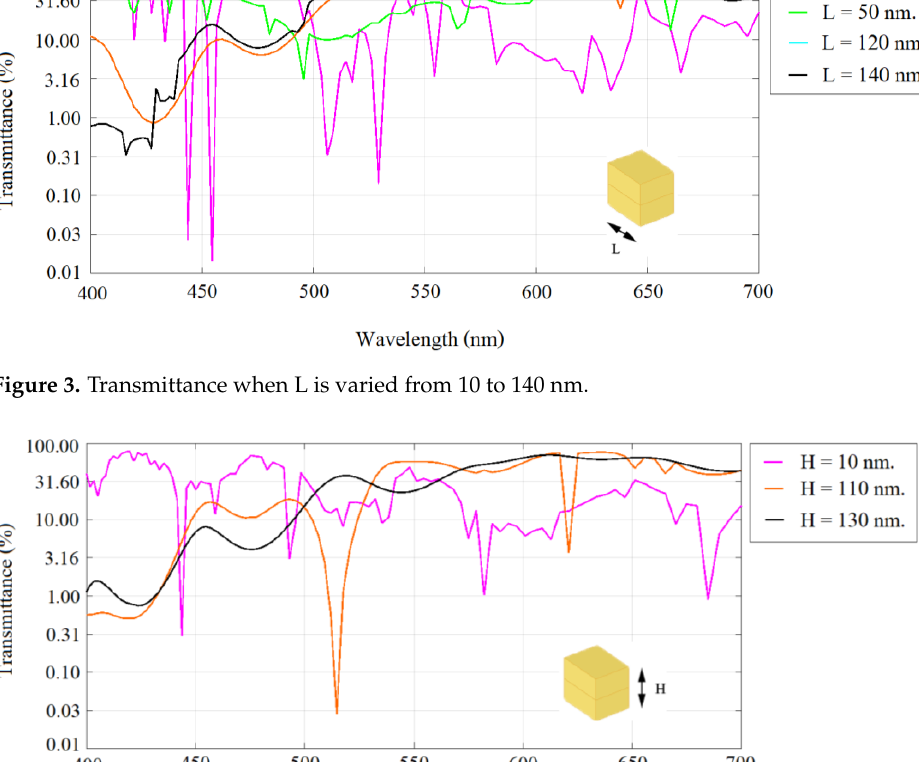
Figure 5. Transmittance when W is varied from 110 to 200 nm.